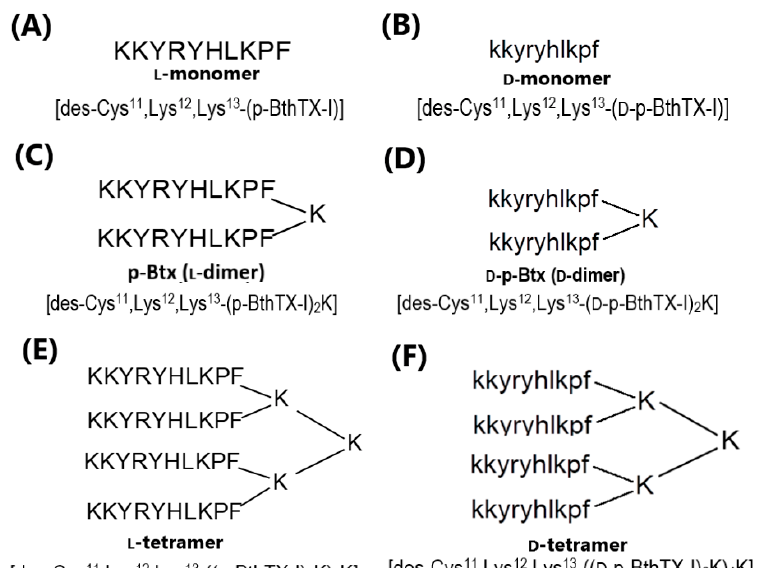
Figure 1. p-Bth peptide analogs, structure, codes and sequences. ( A ) L-monomer, ( B ) D-monomer, ( C ) L-dimer, ( D ) D-dimer, ( E ) L-tetramer, and ( F ) D-tetramer.